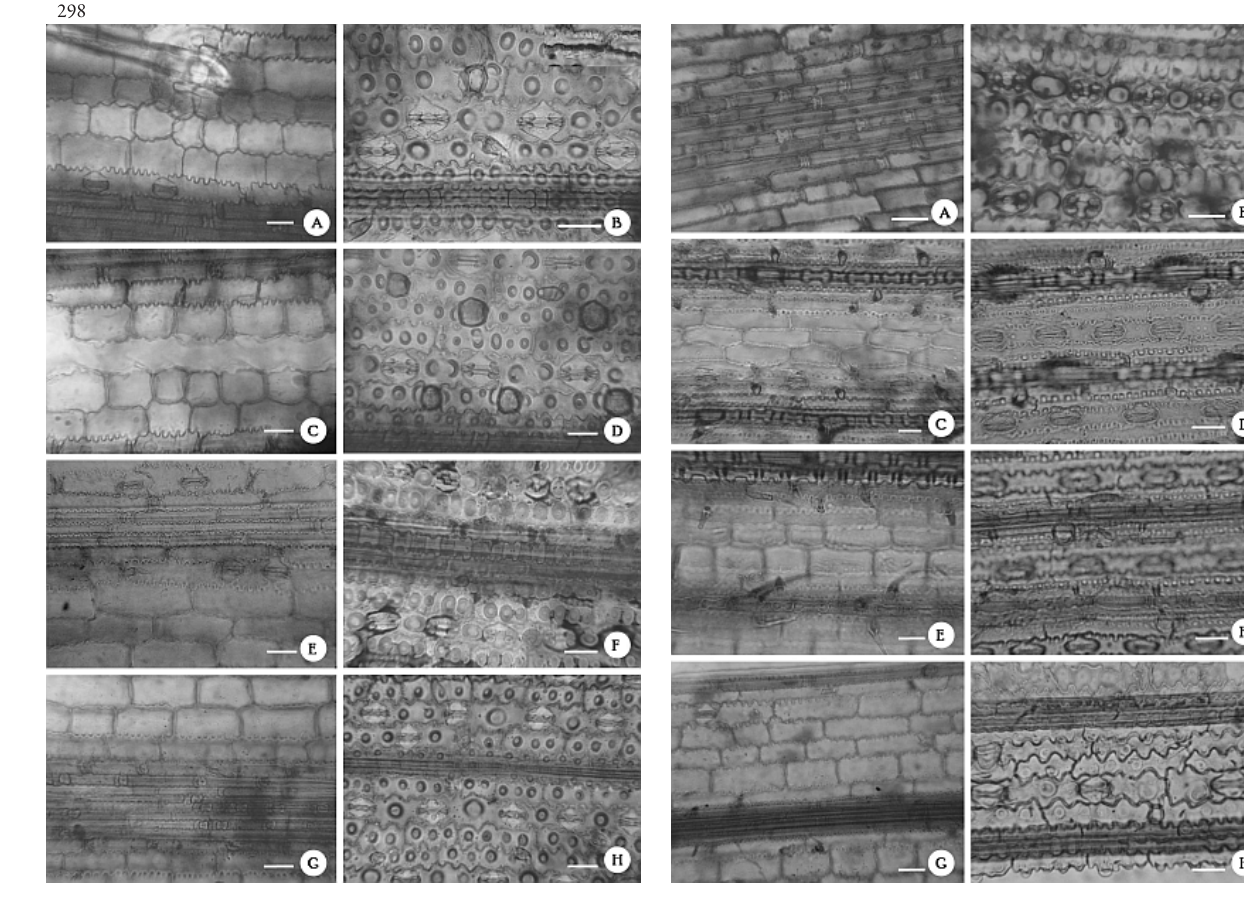
Fig. 3. Photomicrographs of leaf-blades: A, B: Ischaemum ru- gosum ; C, D: I. santapaui ; E, F: I. sayajiraoi ; G, H: I. semisegit- tatum ; A, C, E, G: Adaxial epidermises; B, D, F, H: Abaxial epidermises